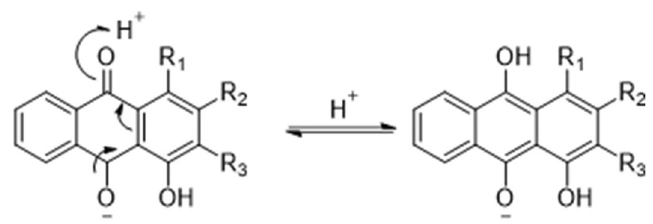
Figure 6. The proposed possible mechanism between C. speciosa , cotton/hemp fabrics, and the pigment of R.